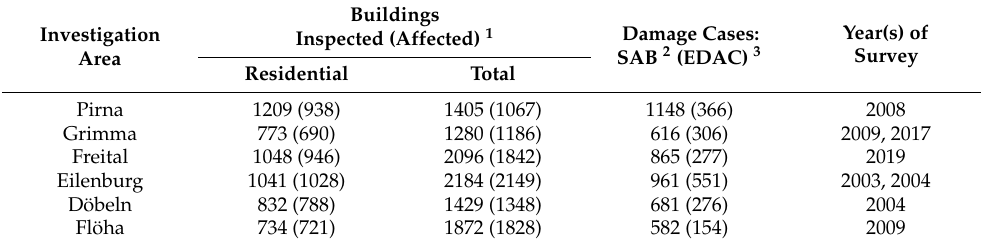
Table 1. Overview of the investigation areas (for interim state cf. [11]).